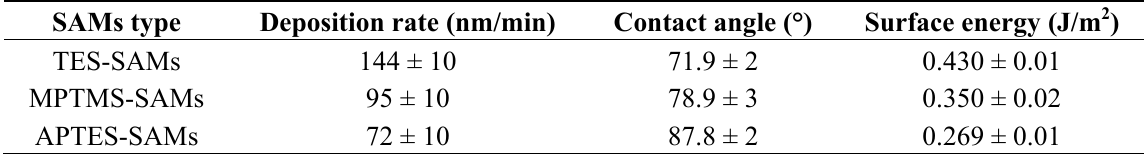
Table 1. Copper deposition rate and contact angle on different self-assembled